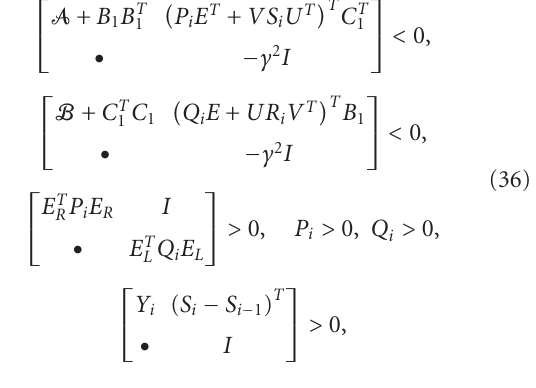
Algorithm 13. It is constructed by using the LMI constraints: